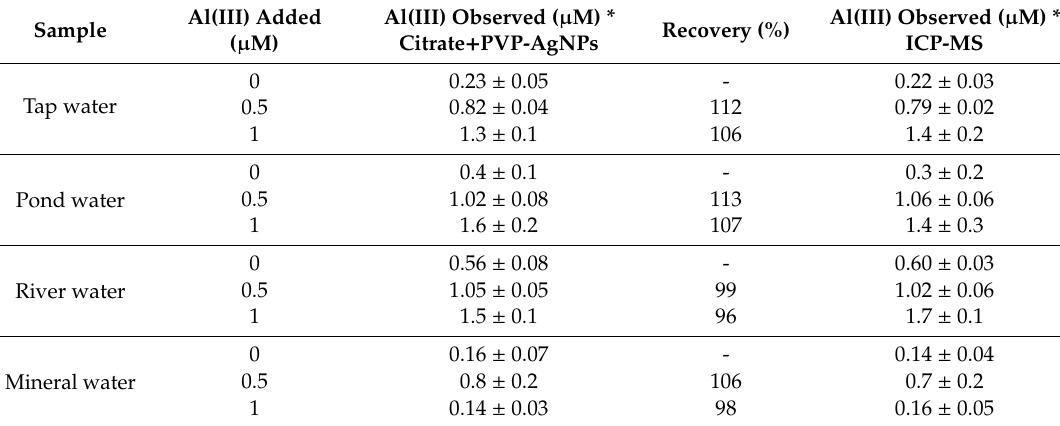
Table 4. Determination of Al(III) in real water samples.